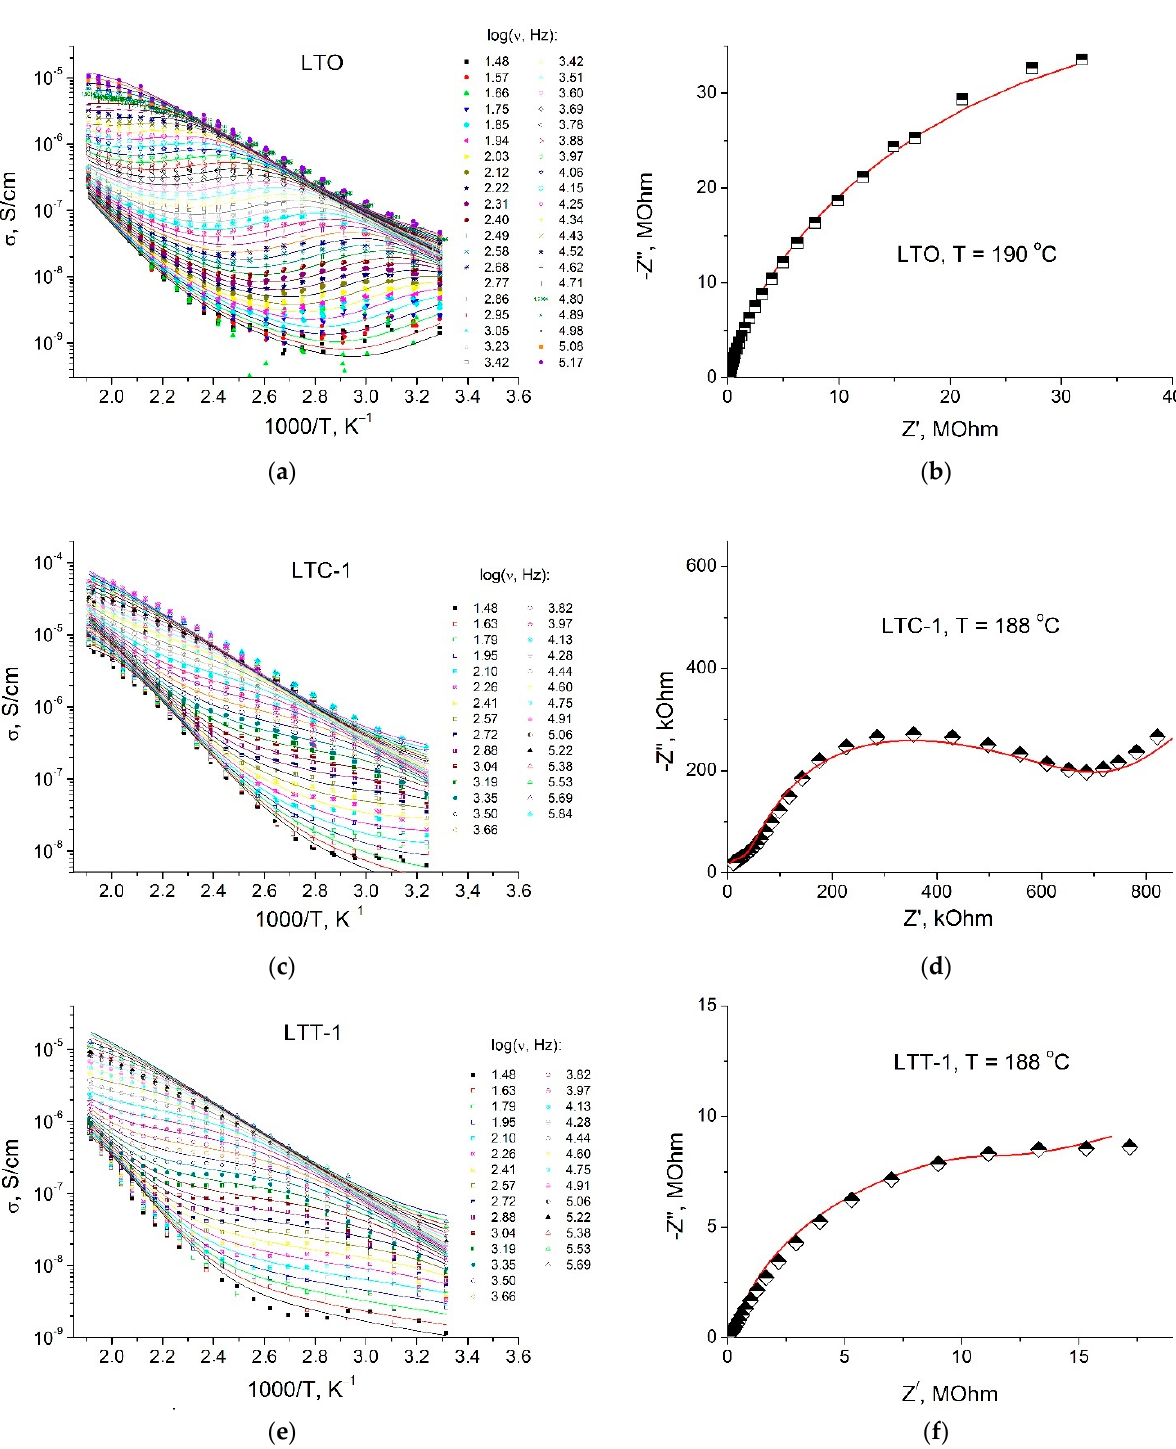
7 of 15 Table 2. Numerical values of the equivalent circuit parameters obtained by fitting. Impedance